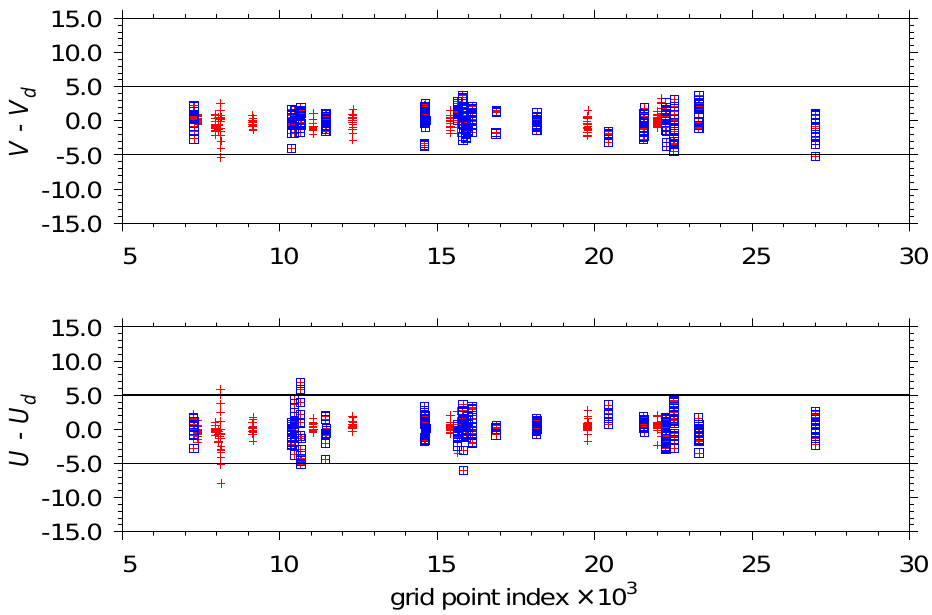
Fig. 16. The upper panel shows the difference between the meridional component of the retrieved velocity (using radar and dropsonde data) and the gridded sounding data. Red marks show this difference for all grid points where there are dropsonde observations, while blue boxes show which of those grid points have radar observations that constrained the retrieved velocity. The horizontal axis is just the grid point index obtained by traversing the grid in C-style order(the last index varying the fastest) The lower panel shows the same, but for the zonal component of the